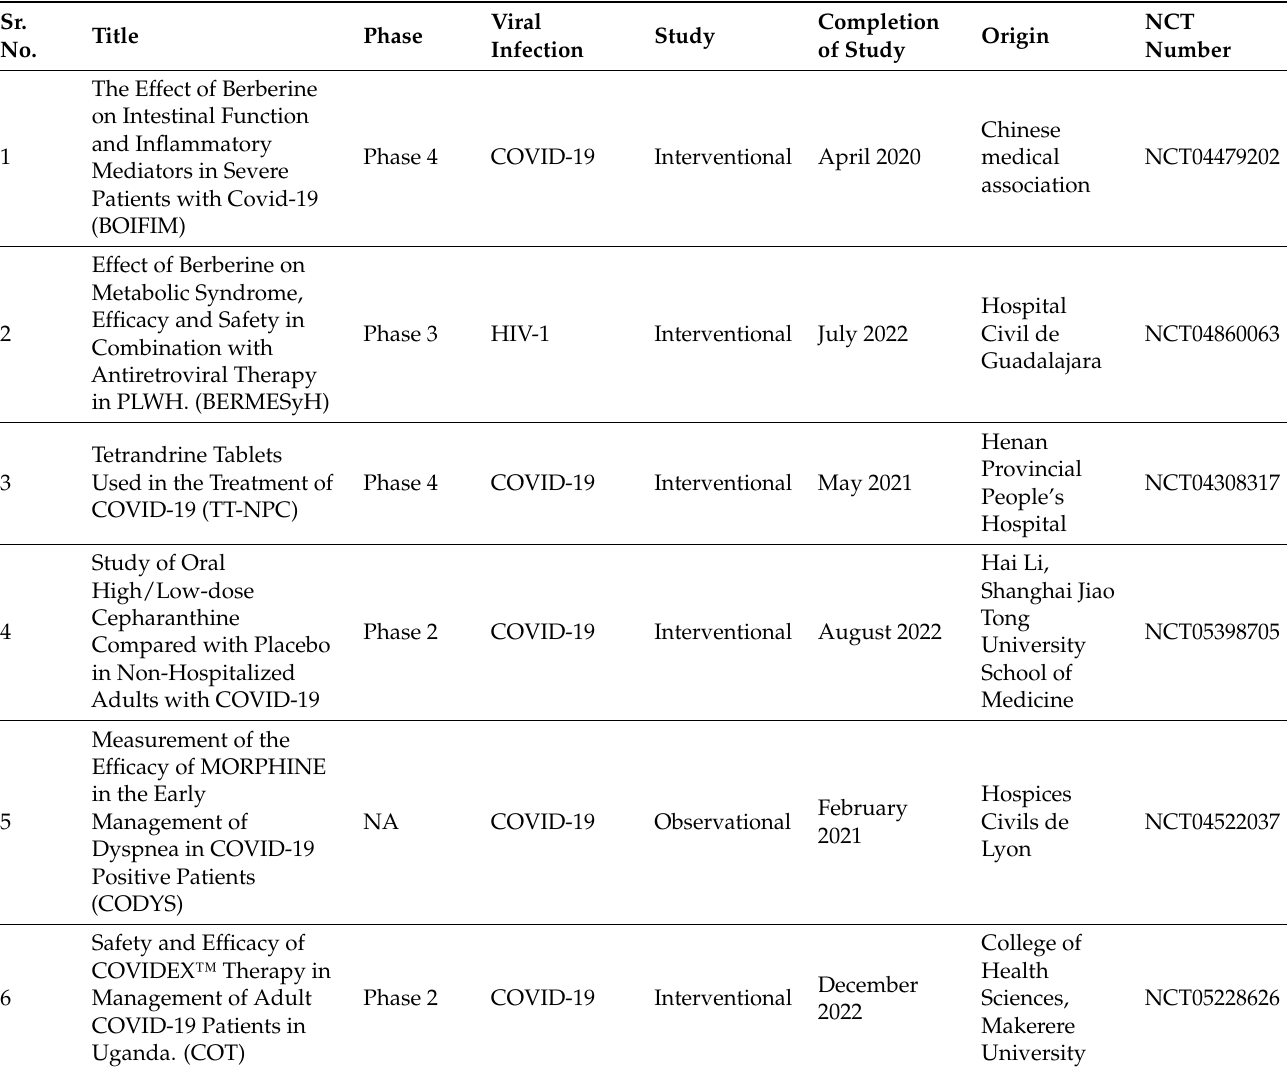
Table 3. Clinical trials of isoquinoline alkaloids against viral